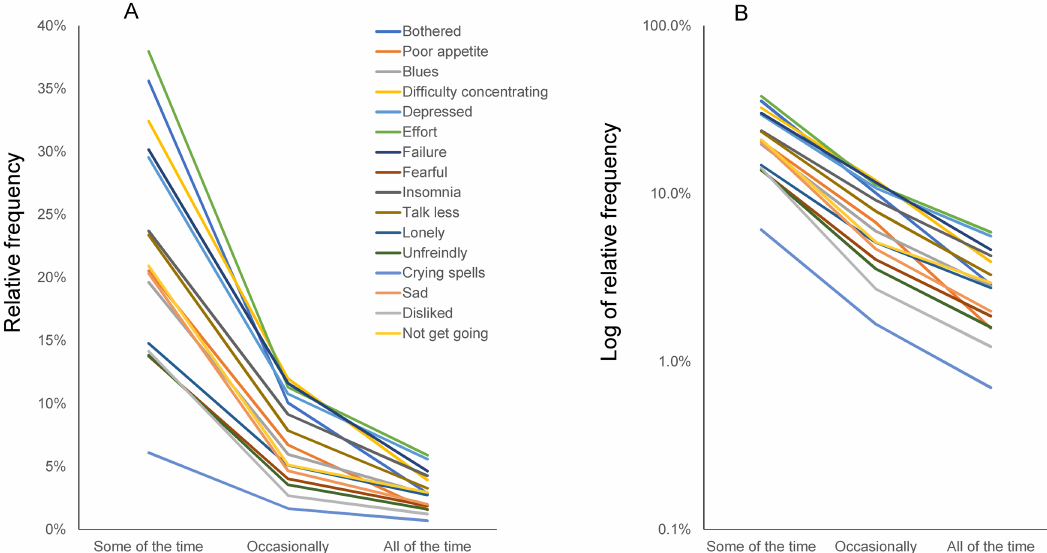
Fig 2. Item responses for the 16 depressive symptom items from “some of the time” to “all of the time” in the Japanese survey. Item responses to the 16 items from “some of the time” to “all of the time” on a normal scale (A) and a log-normal scale (B). (A) The lines for the 16 items converge between “some of the time” and “all of the time.” (B) Item responses follow a parallel pattern between “some of the time” and “all of the time” on a log-normal scale. Reprinted from [9]. Image credit: PLoS ONE at